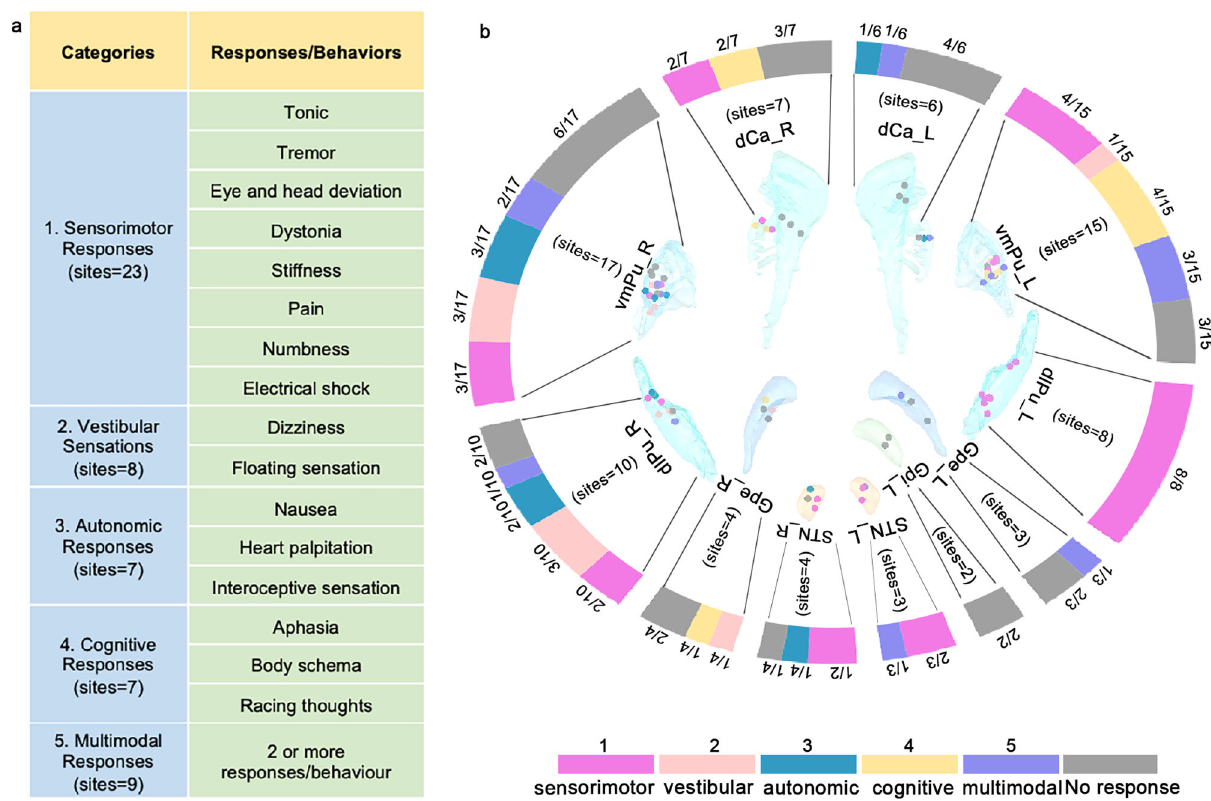
Fig. 3 Direct electrical stimulation elicited diverse responses. a Elicited responses/behaviors were classi fi ed into fi ve categories based on their properties. b The spatial distribution of contacts and the rate of different responses/behaviors elicited within the BG subnucleus. The response categories are